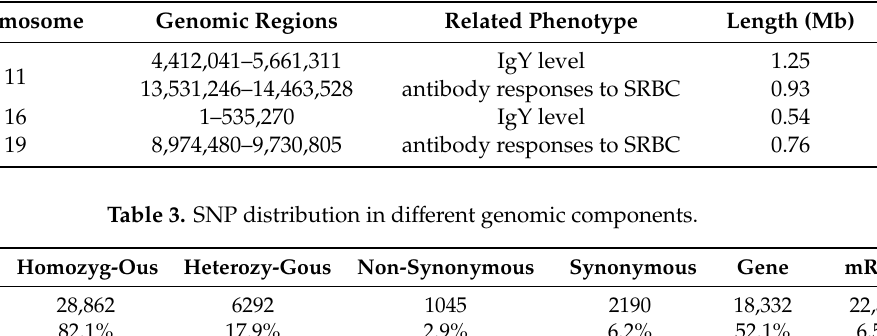
Figure 1. Summary of genetic mutations between high and low IgY White Leghorn and Beijing-You chickens. ( A ) Summary of single nucleotide polymorphisms (SNPs). ( B ) Summary of Indels. Table 2. Genomic regions covered by sequence capture chip.